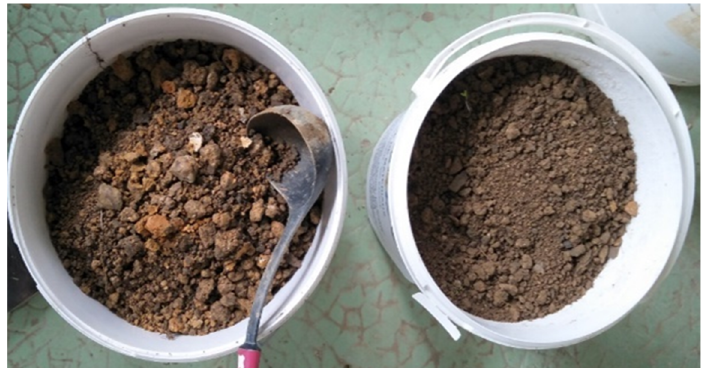
Figure 8. NTC ( left ) and MTC ( right ) from Yzernay site.